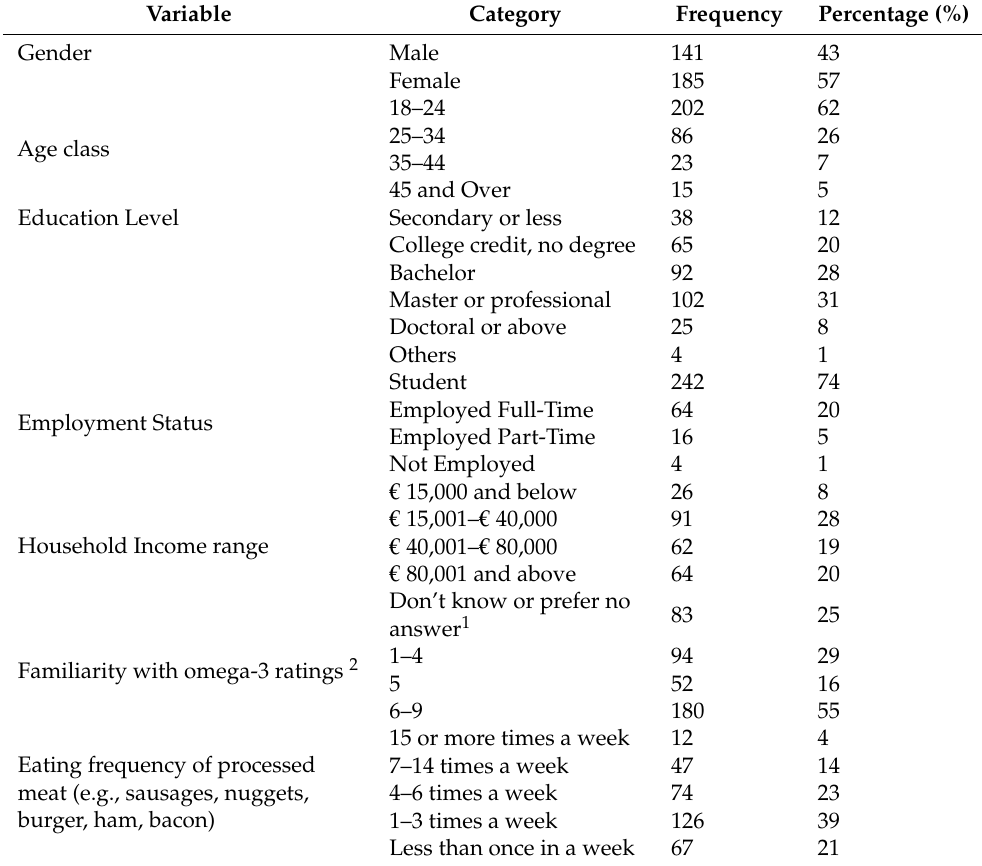
Table 2. Participants’ socio-economic and demographic characteristics. Note: 1 About twenty-five per cent of respondents did not know or preferred not to answer the level of household income, who were assigned an average income level for further analysis. 2 Omega-3 familiarity was self-assessed using a structured 9-point hedonic scale, where 1 = “extremely unfamiliar”, 5 = “neither unfamiliar nor familiar”, and 9 = “extremely